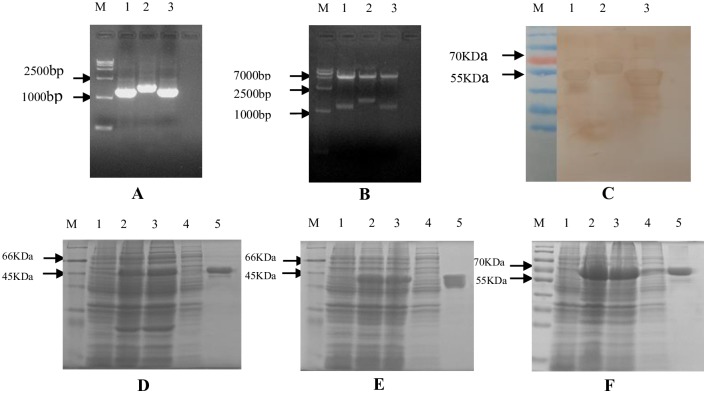
Preparation and identification of three PspA proteins.(A and B) Identification results obtained by PCR (A) and enzyme digestion (B) of three PspA expression plasmids. M: DNA Marker; Lane 1: PspA1 protein; Lane 2: PspA3 protein; Lane 3: PspA2 protein. (D–F) SDS-PAGE results for recombinant proteins PspA1, PspA2, and PspA3 in sequence. M: Marker; Lane 1: empty vector control; Lane 2: recombinant protein 4 h after induction with IPTG; Lane 3: supernatant of recombinant protein after sonication; Lane 4: precipitation of recombinant protein after sonication; Lane 5: supernatant of recombinant protein after purification. (C) Western blot analysis results of PspA proteins. M: Marker; Lane 1: recombinant protein PspA1; Lane 2: recombinant protein PspA3; Lane 3: recombinant protein PspA2.